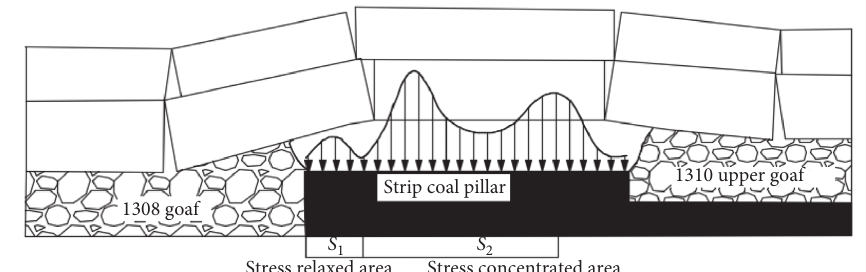
Figure 6: Distribution of abutment pressure on strip coal